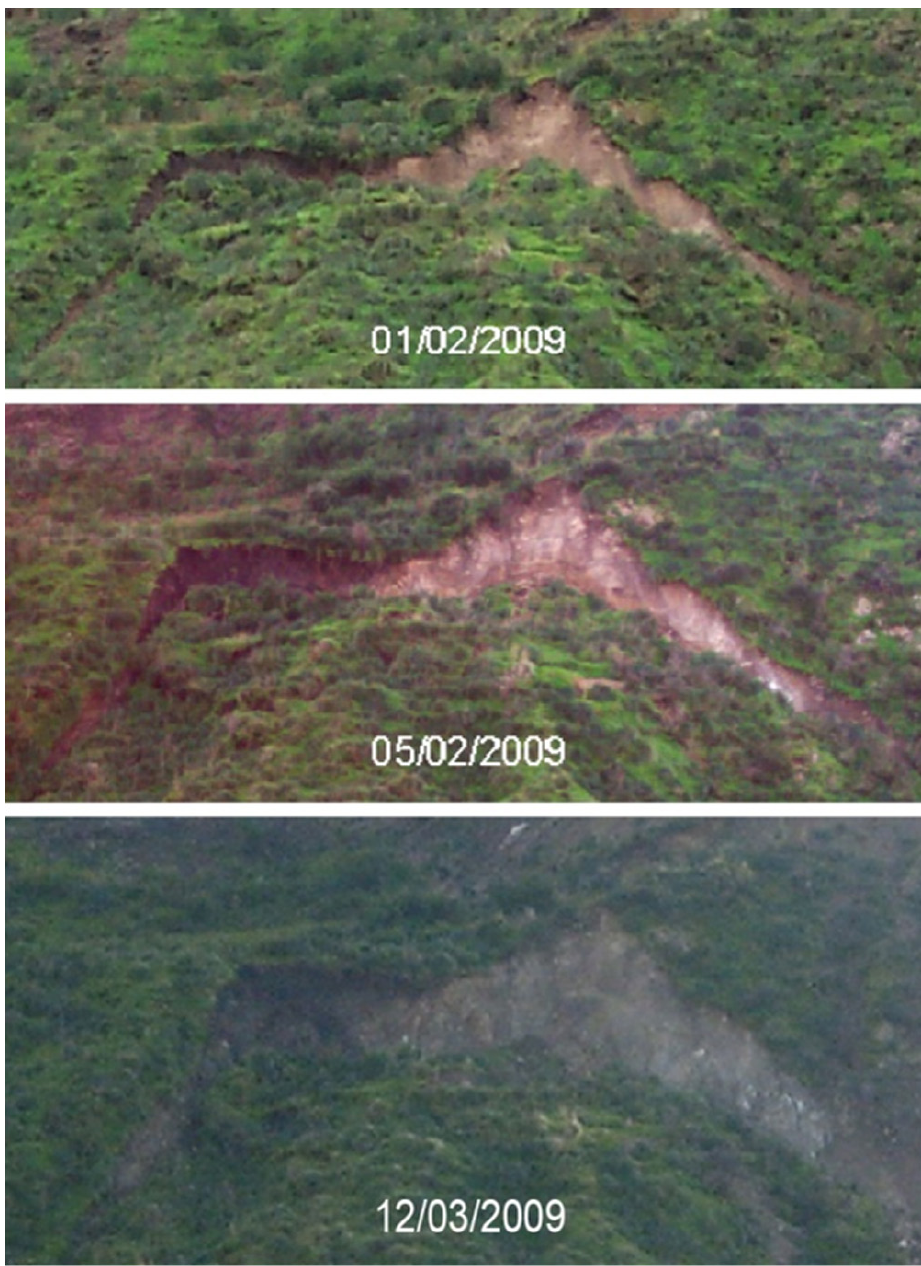
Fig. 3. Pictures of a fracture placed above the landslide. The widening of the fracture with time is clearly visible.